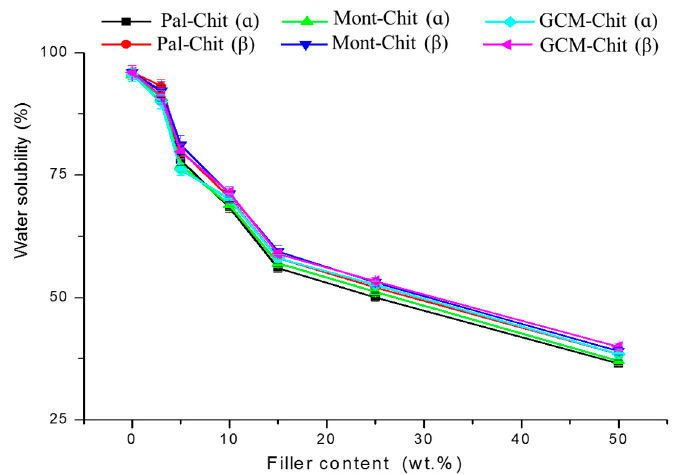
Figure 4. Evolutions of water solubility of the films against filler content. Chit: chitosan; Pal: palygorskite; Mont: montmorillonite; GCM: geopolymer-containing material.